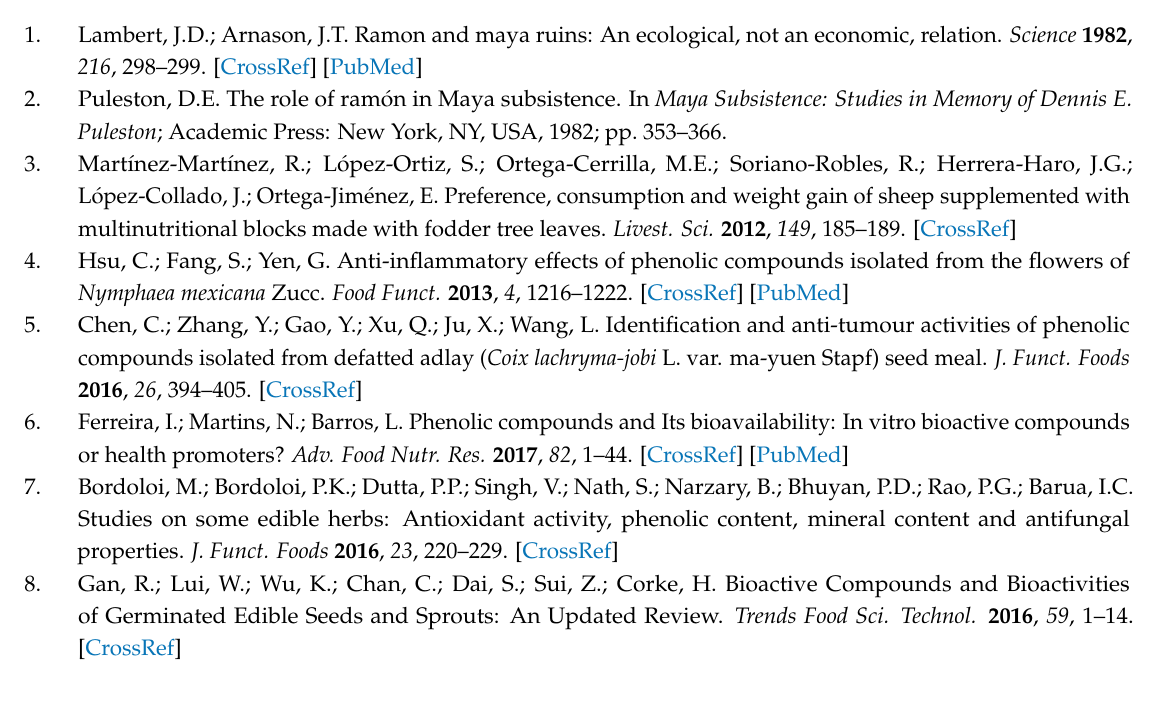
Supplementary Materials: The following are available online. Figure S1: Standard curve of Gallic acid, Figure S2: Standard curve of